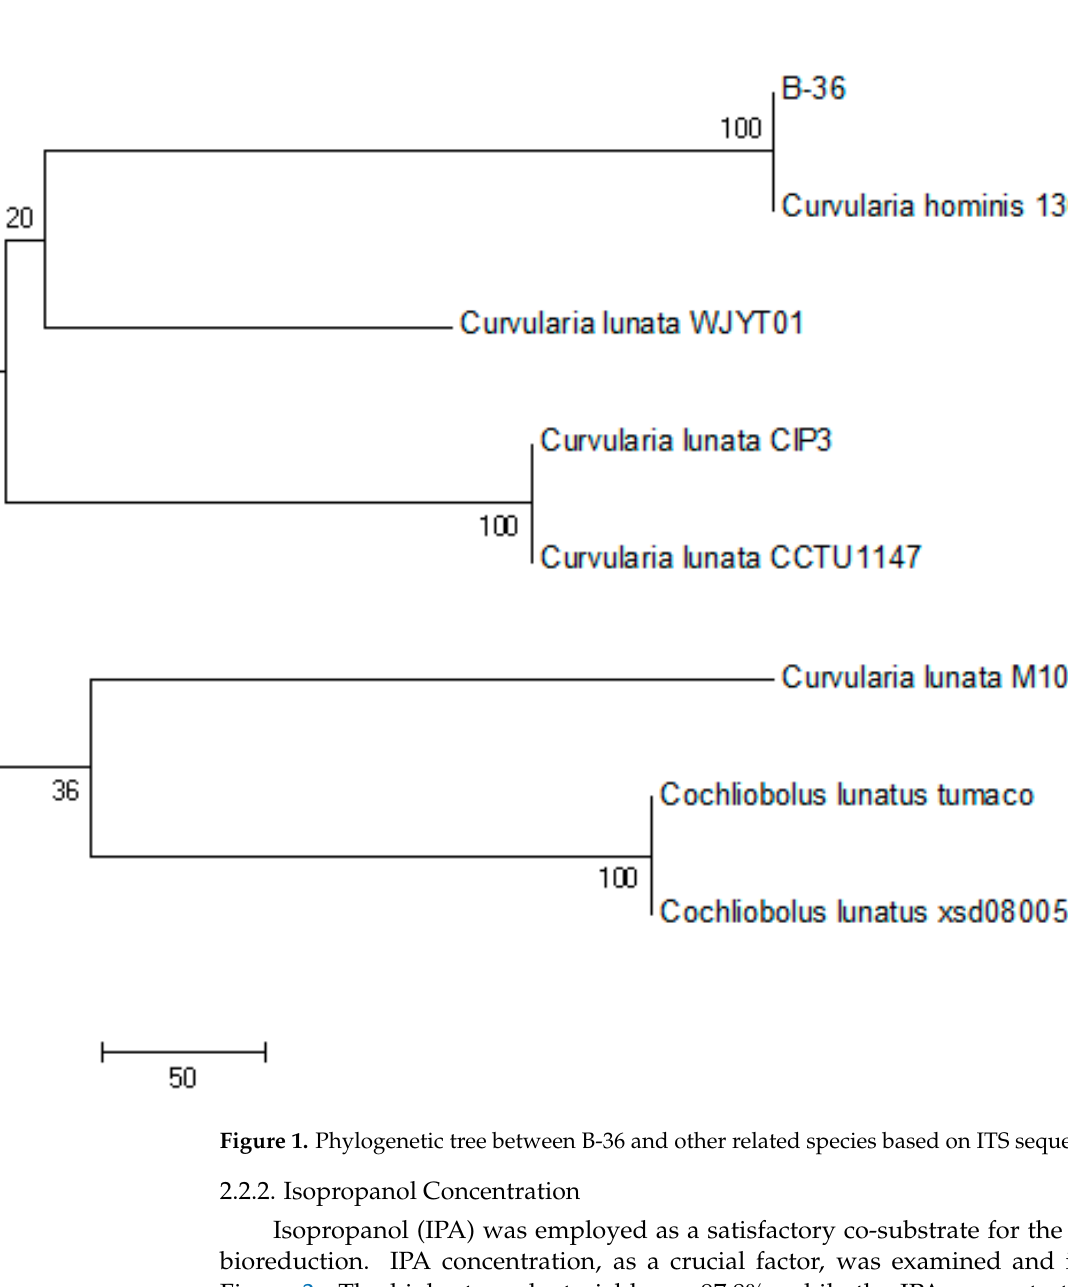
Figure 2. Effects of co-substrates on the biocatalytic reduction. Reaction conditions: 20.0 mL phos- phate buffer (100 mM, pH 6.0), 1.0 g resting cells (DCW), 50 mM 1-chloro-2-heptanone, 15% ( v/v ) various co-substrate, 200 rpm, 30 °C, 24 h. Symbols: 0: control (without co-substrate); 1: isopropanol; 2: ethanol; 3: methanol; 4: glycerol; 5: glucose; 6: sucrose; 7: fructose; 8: lactose. 2.2.2. Isopropanol Concentration Isopropanol (IPA) was employed as a satisfactory co-substrate for the asymmetric bioreduction. IPA concentration, as a crucial factor, was examined and is shown in Figure 3. The highest product yield was 97.8%, while the IPA concentration reached 15%. The product yield was improved with the IPA concentration increased to 15%, which declined